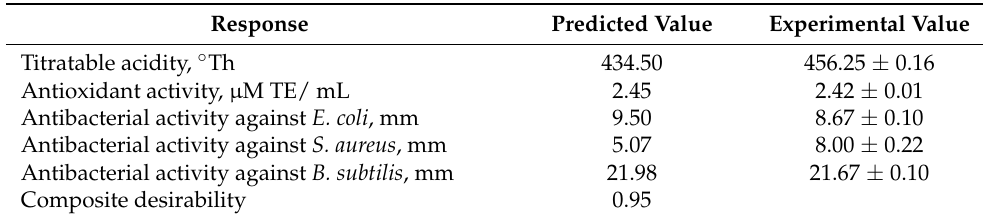
Model validation of the studied biotechnological parameters for the optimized fermented